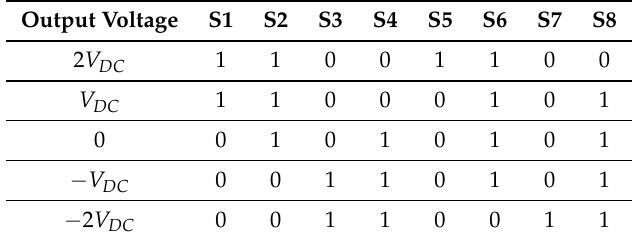
Table 10. 5L-CMLI switching